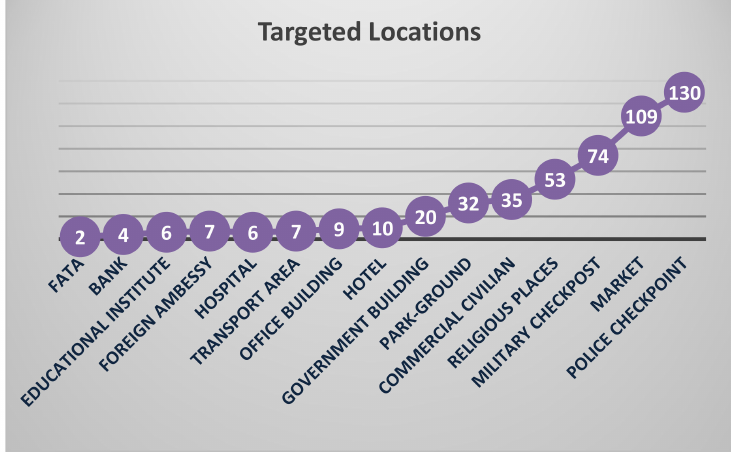
Figure 4. Visual analysis of the locations targeted by suicide